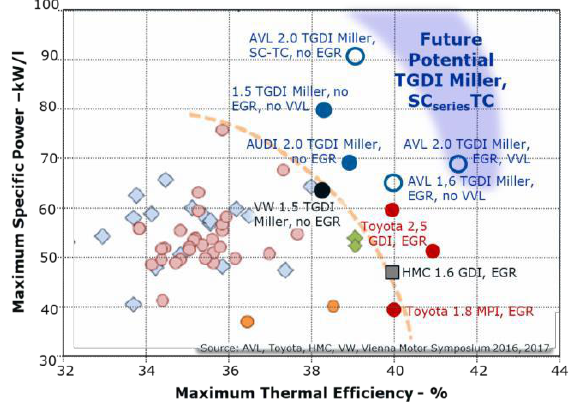
Fig. 14. Trade-off between max. efficiency and max. specific performance Looking at the state of the art, Miller/Atkinson concepts represent the most attractive low-consumption solutions.